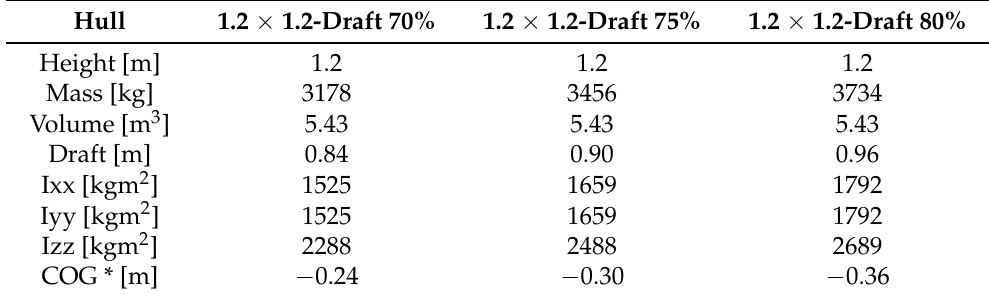
Table 6. Configuration parameters of hull draft sensitivity analysis.